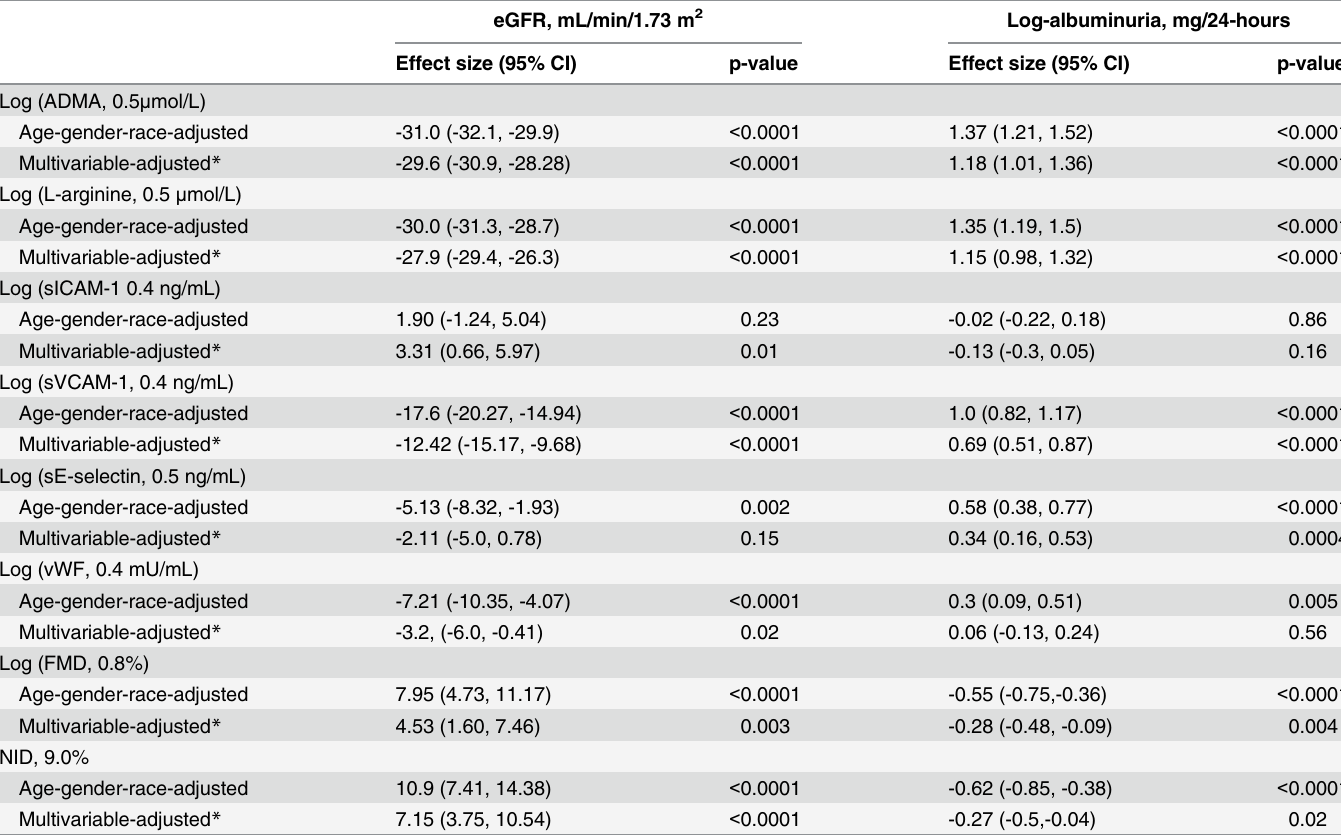
Table 3. Multivariable-Adjusted Regression Coefficients (95% Confidence Intervals) of One Standard Deviation Higher Log-transformed Endothe- lial Dysfunction Biomarkers with Estimated-GFR and Log-transformed Urinary Albumin Excretion.